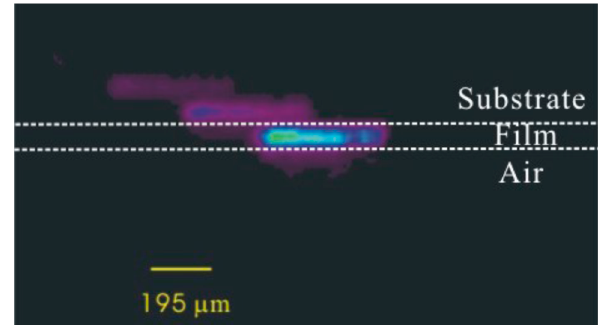
Figure 9. Luminescence image of Nd:YAB thin film (image artefacts to the upper left).